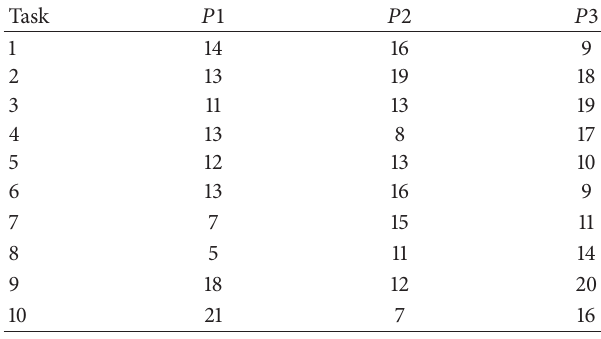
Table 2: Computation costs.